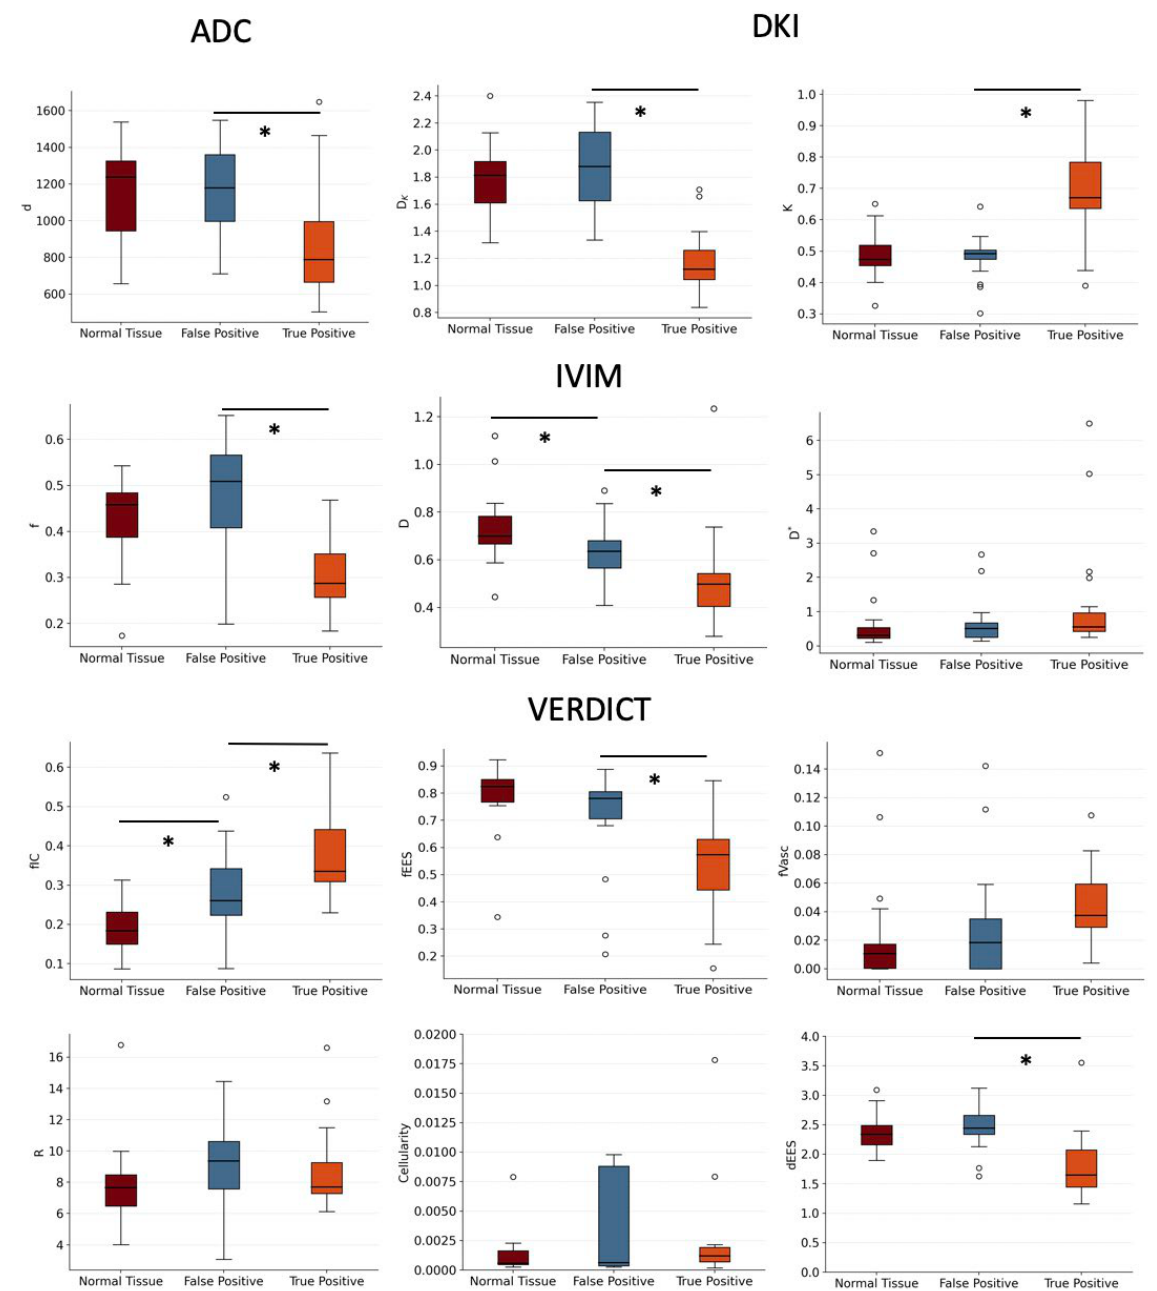
Figure 2. Boxplots showing the parameter estimates obtained using the ADC, DKI, IVIM and VERDICT models. We observed significant differences between true and false positives in the ADC d ( p = 0.002); IVIM D ( p = 0.01) and f ( p = 0.0002); DKI D K ( p < 0.0001) and K ( p = 0.0001); and VERDICT f IC ( p = 0.001), f EES ( p = 0.002) and d EES ( p = 0.0004). The d , D K , D , f , f EES and d EES are all lower in true positives than false positives, while K and f IC are higher. We also found statistically significant differences between false positives and normal tissue for the VERDICT f IC ( p = 0.004), with higher values in false positive lesions than in normal tissue, and the IVIM D ( p = 0.02) with lower values in false positive lesions than in normal tissue. Outliers are denoted by a circle and asterisks indicate statistical significance.